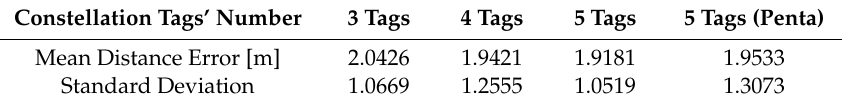
Figure 7. Constellation of tags with different number of tags. Table 2. The mean estimated distance errors for different constellations. Constellation Tags’